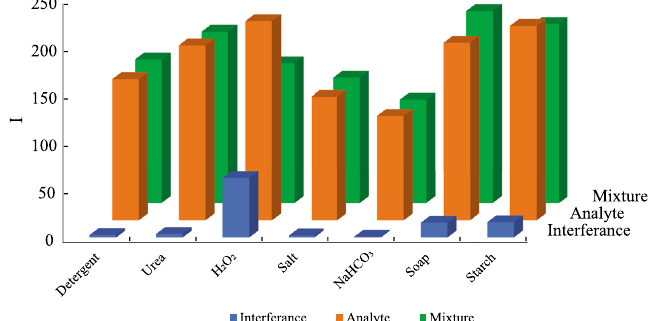
Figure 6. The difference in color intensity of the adulterant mixture and the single adulterant is shown here. The maximum interference is found at about 30% for hydrogen peroxide but for all other cases it is less than 10% .